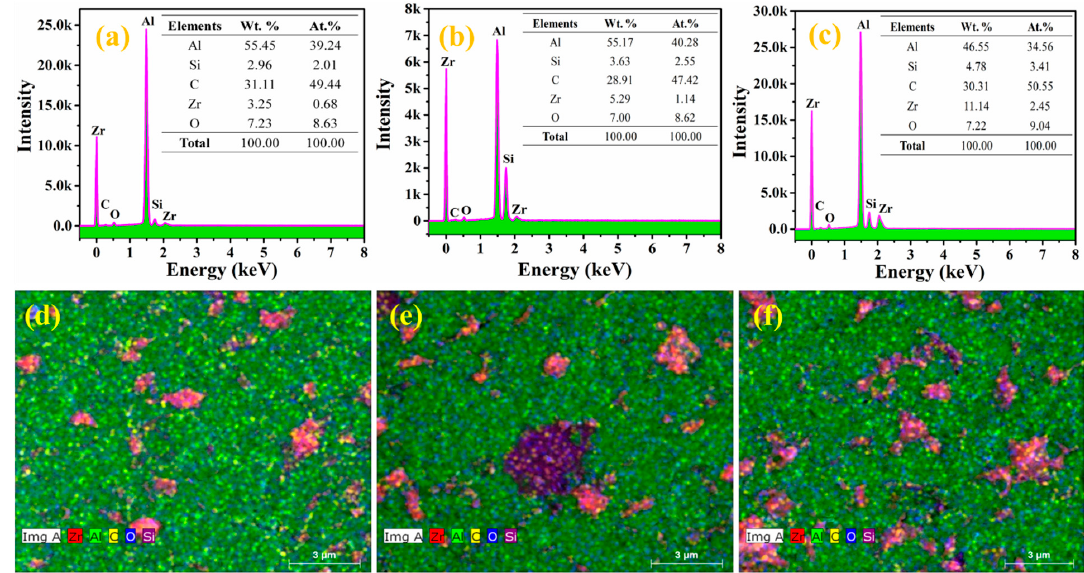
Figure 4. ( a – c ) Energy-dispersive X-ray spectroscopy (EDX) spectrum and ( d – f ) elemental mapping of Al-5SiC-3ZrO 2 , Al-5SiC-6ZrO 2 , and Al-5SiC-9ZrO 2 nanocomposites respectively.